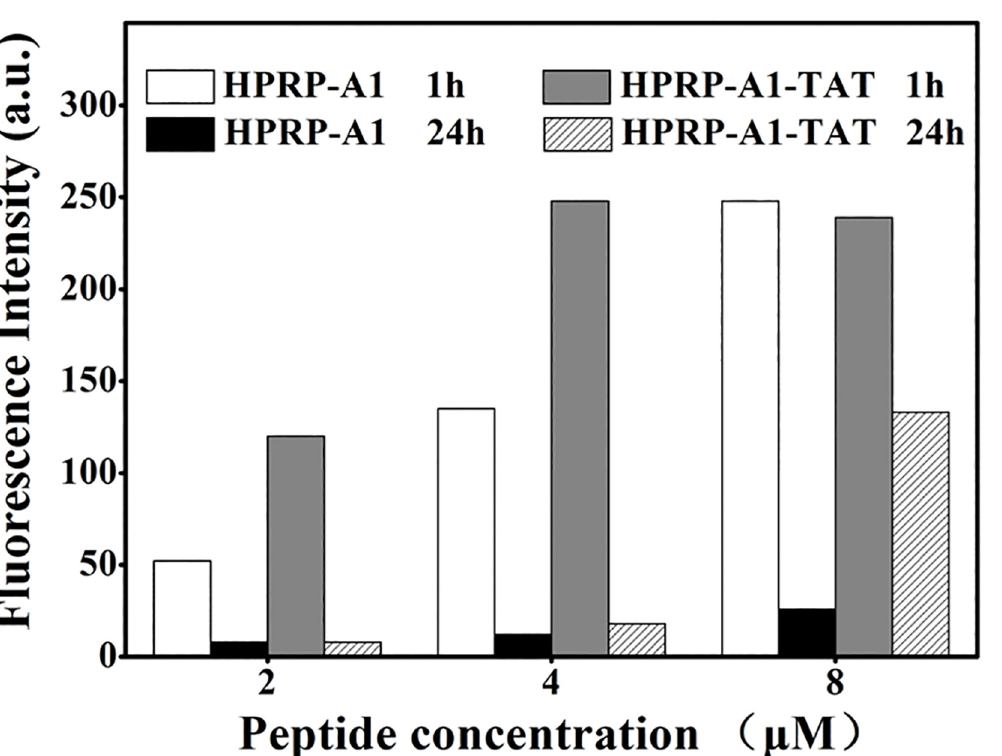
Fig 4. The degradation of peptides by flow cytometry analysis. HeLa cells were incubated with FITC-labeled peptides (2, 4, or 8 μ M) for 1 or 24 h. Cellular uptake of peptides is expressed as the median of cell fluorescence distribution by flow cytometry.